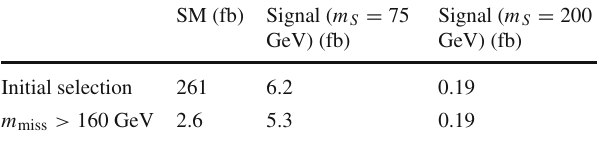
Table 1 Signal (for λ HS = 1) and SM background cross sections (in fb) for the idealized luminosity spectrum L γγ ( y ) ∝ δ( y − y max ) for √ s | ee = 3 TeV, after the initial event selection (4 hadronic CLIC with (cid:10) (cid:10) (cid:10) < 4 . 5, that are paired to reconstruct (cid:10) η > 20 GeV and jets with p j j T two W -bosons), and after the cut m miss > 160 GeV. The cuts are the √ s | ee = 1 TeV same for ILC with SM (fb) Signal ( m S = 75 GeV) (fb)